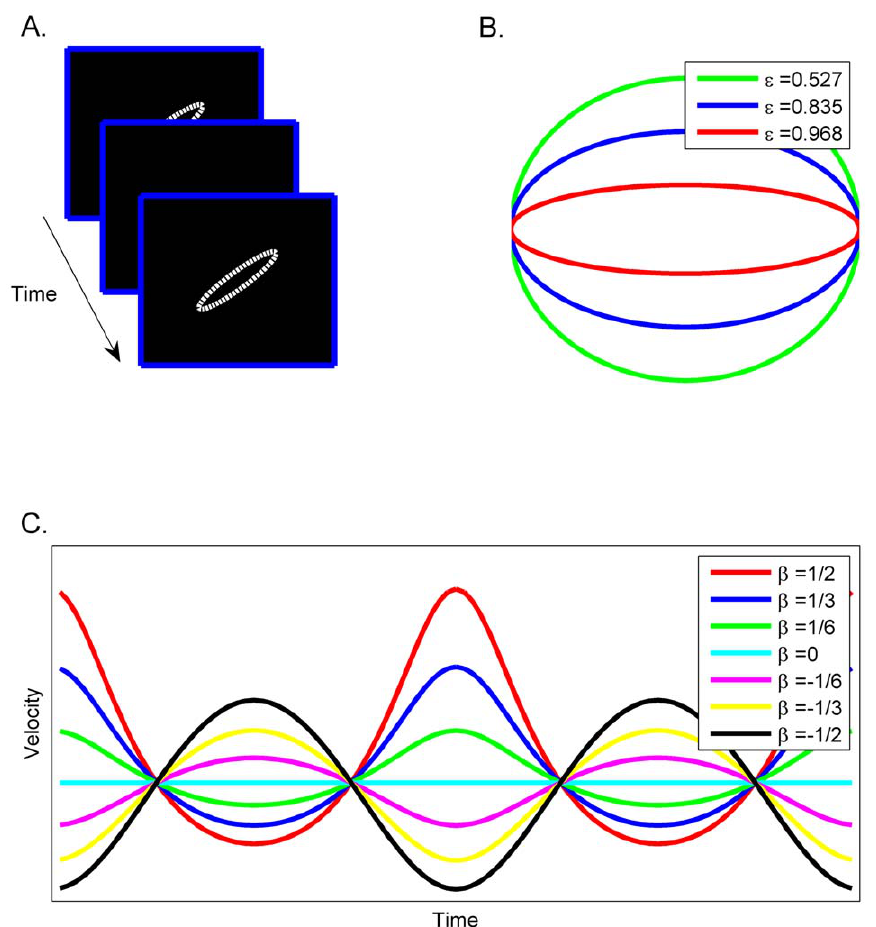
Figure 1. Experimental design and stimuli. (a) Subjects viewed a white light spot on the computer screen moving in elliptical trajectories. They were asked to modify its motion until it appeared to move most uniformly. (b) Ellipse eccentricity ( e ) (c) Velocity profiles for the ellipse with medium eccentricity ( e =0.835).